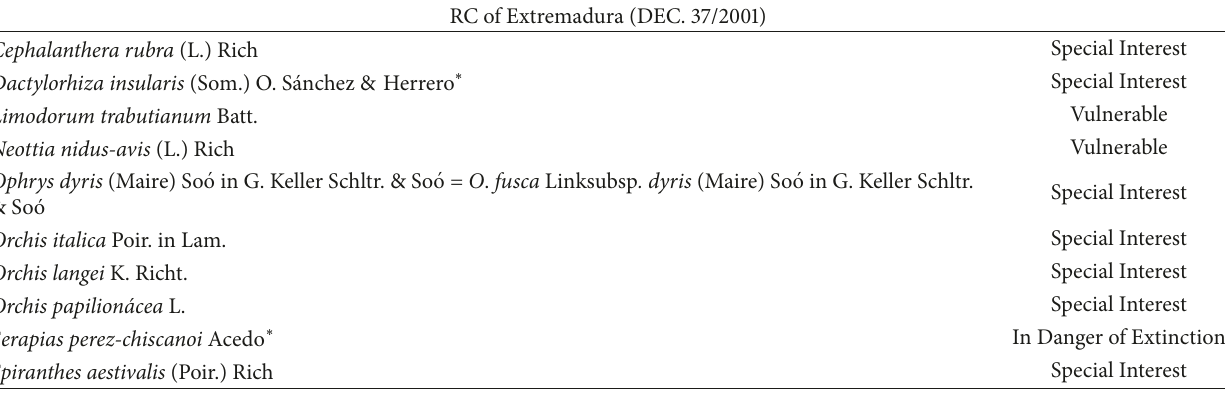
Table 15: Species included in the regional catalogue (RC) of Extremadura (DEC. 37/2001). RC of Extremadura (DEC. 37/2001)